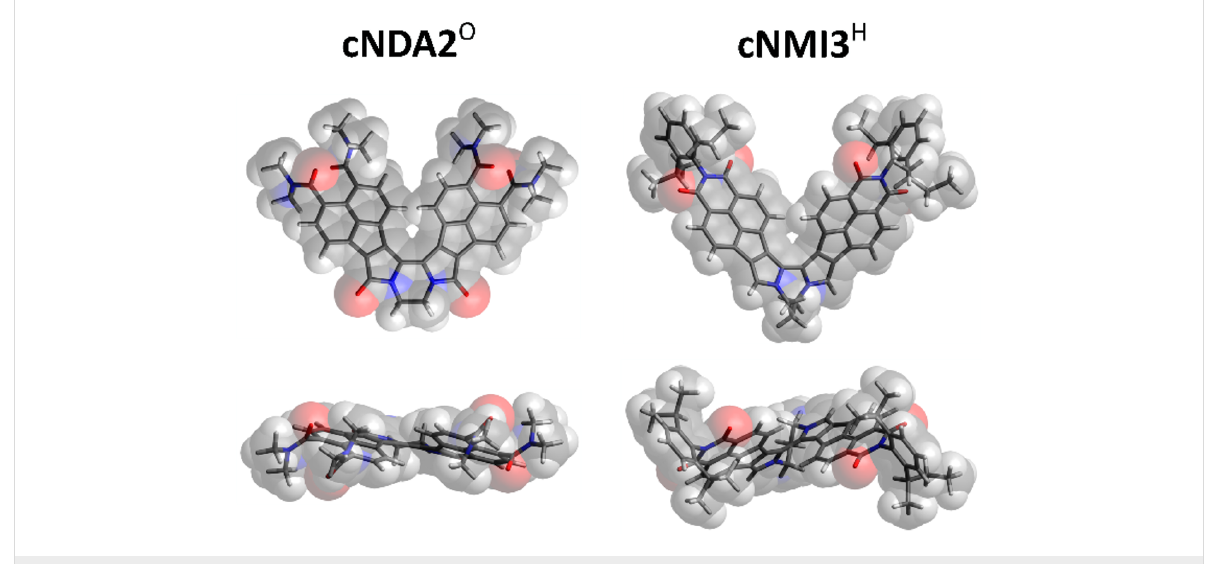
Figure 1: DFT-Optimized structures (B3LYP/6-31G(d,p)) of cNDA2 O and cNMI3 H .